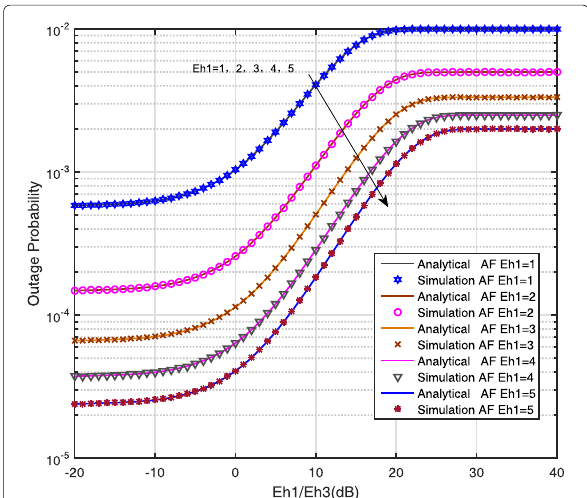
Because a lower γ th means a lower probability, the SNR at each receiver falls below the threshold. Further, out- age probability becomes worse when the value of E h 1 / E h 2 increases, because the increasing value of E h 1 / E h 2 means the S - D link becoming worse too, resulting in a lower diversity gain at node D . In Fig. 10, the outage probability curves under DF and AF schemes are depicted where E h 2 = E h 3 = 1.